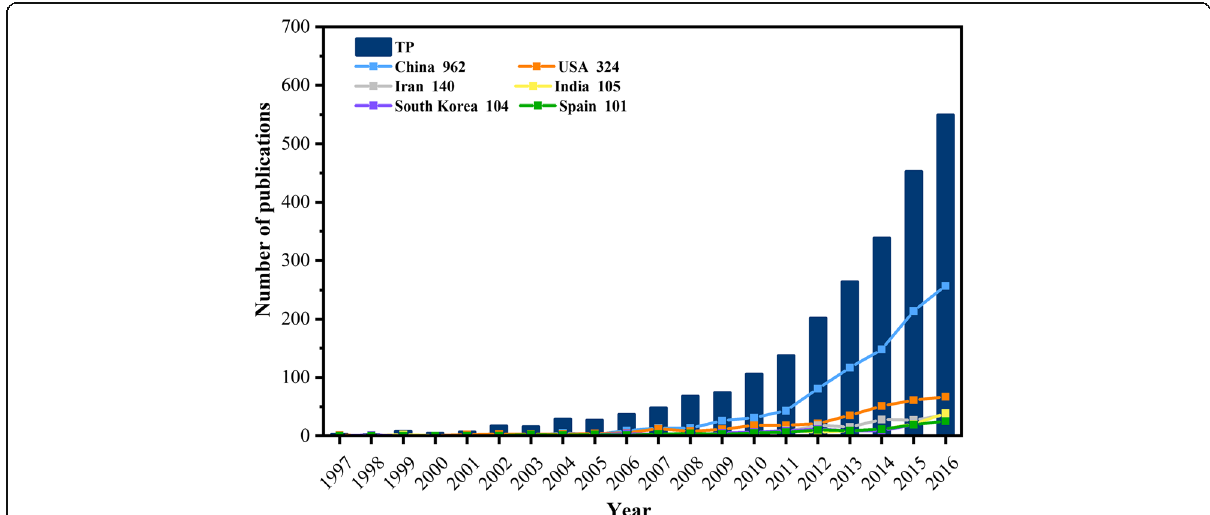
Fig. 1 The annual publication number of top six productive countries during 1997 – 2016. TP: the total number of publications. The number after the country is the total publications of this country in this field over the time span